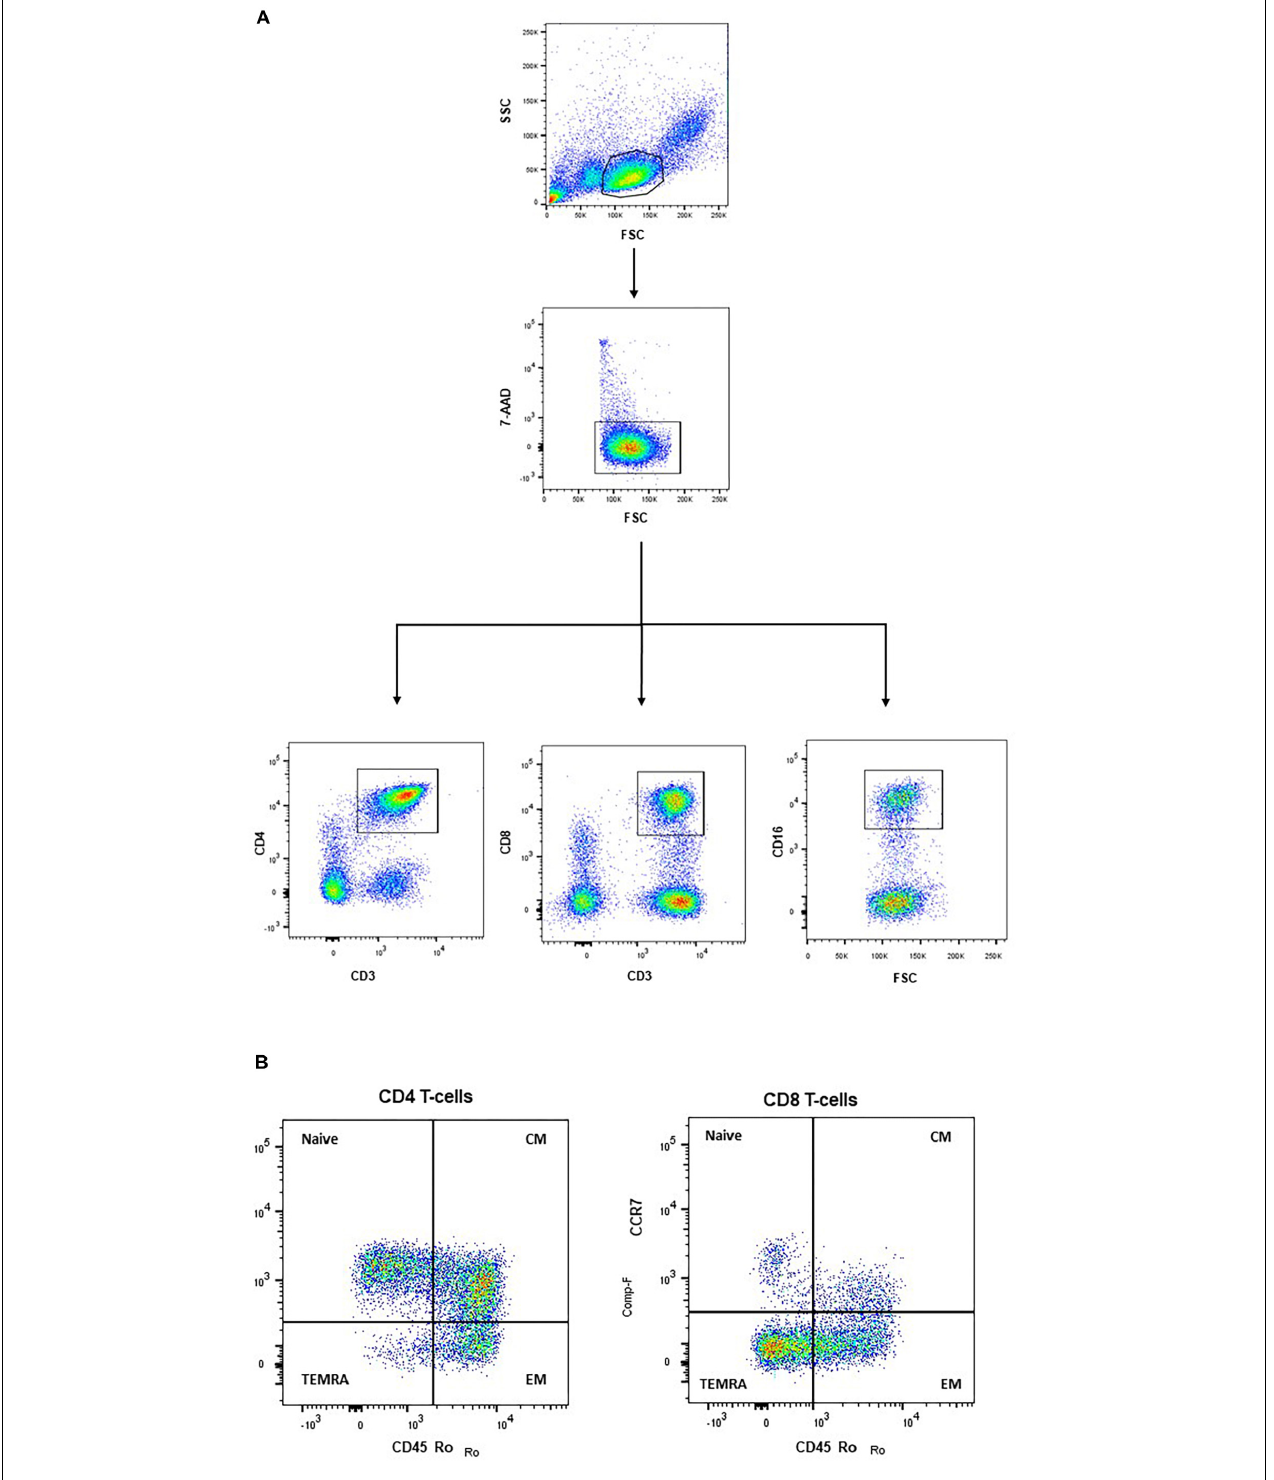
FIGURE 1 | Frozen PBMCs were defrosted and stained with fluorochrome-conjugated antibodies. Gating strategy: Lymphocytes were gated in a FSC/SSC-dot plot and dead cells excluded using 7-AAD. From the living cell population, CD4 T-cells, CD8 T-cells and CD16 + cells were gated according to their specific surface markers (A) . T-cell subpopulations, within CD4 and CD8 T-cells, respectively, were defined by staining CD45RO and CCR7. NAIVE (CD45RO-/CCR7+): naive T-cells; CM (CD45RO+/CCR7+): central memory; EM (CD45RO+/CCR7-): effector memory; TEMRA (CD45RO-/CCR7-): effector memory + RA (B) .